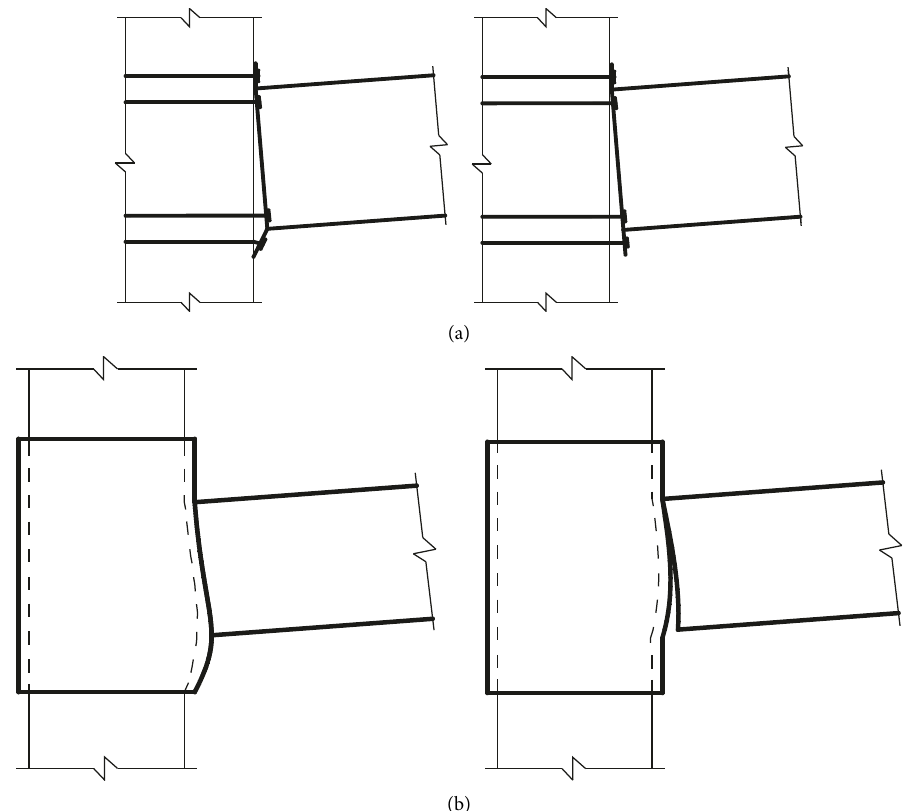
Figure 10: Comparison of failure modes of two semirigid joints. (a) Extended end-plate joint. (b) Sleeve joint.